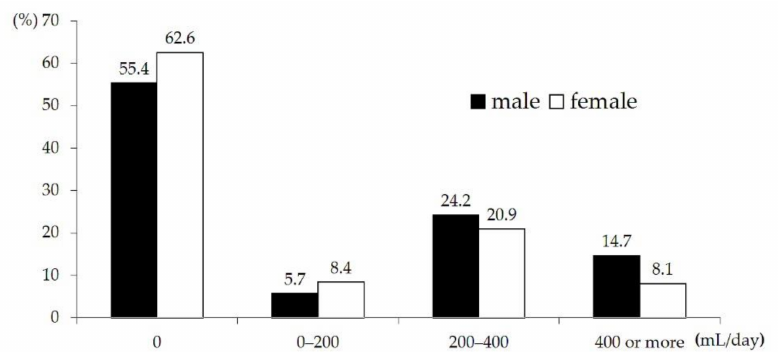
Figure 1. Distribution of daily milk